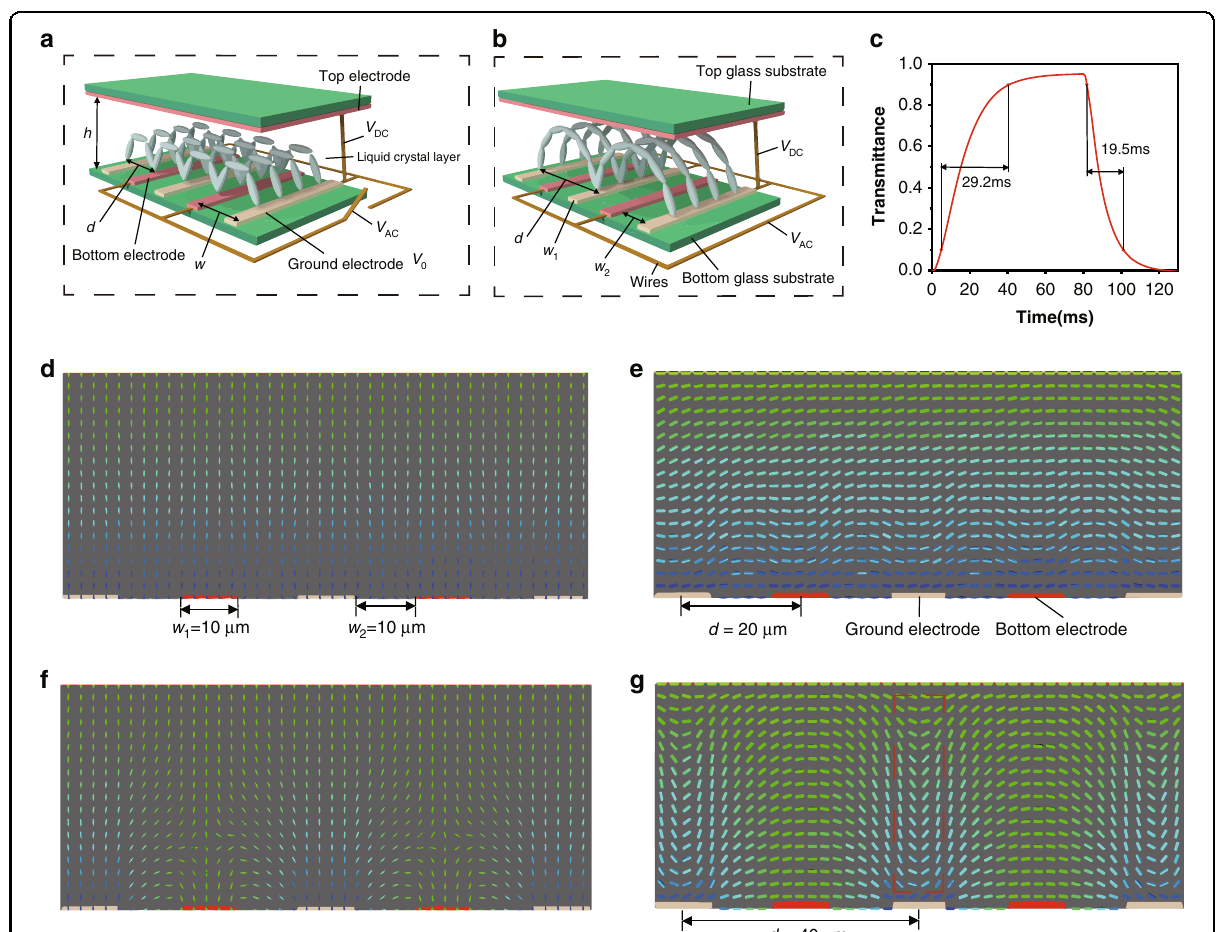
Fig. 3 Design of the tunable liquid crystal grating. a Distribution of the tunable liquid crystal molecules in the small periodic order. b Distribution of the tunable liquid crystal molecules in the large periodic order. c Response time of the tunable liquid crystal grating ( w 1 = w 2 = 10 μ m, the maximum light transmittance is 95%). d Intensity distribution of the electric fi eld distribution ( V DC = 3.7 V, V AC = 0 V). e Liquid crystal molecular distribution in the small periodic order ( V DC = 3.7 V, V AC = 0 V). f Intensity distribution of the electric fi eld distribution ( V DC = 4 V, V AC = 4.5 V). g Liquid crystal molecular distribution in the large periodic order (